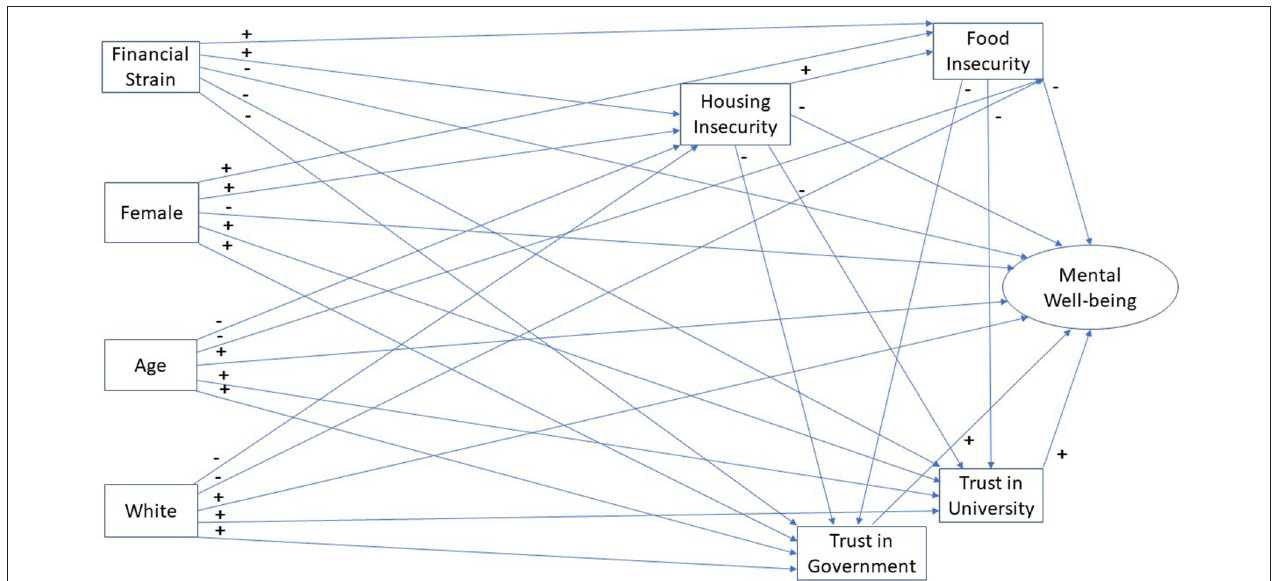
FIGURE 1 | Conceptual model of university student mental